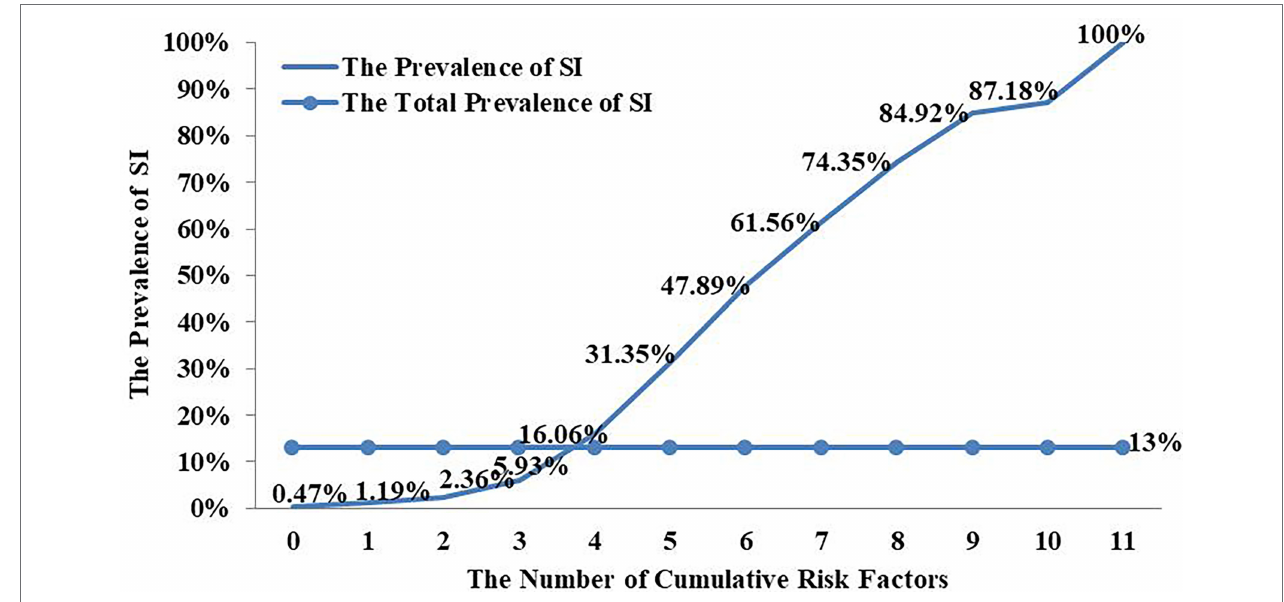
FIGURE 2 | SI risk among Chinese adolescents from Grade 8 to 12 under different Cumulative risk factors.